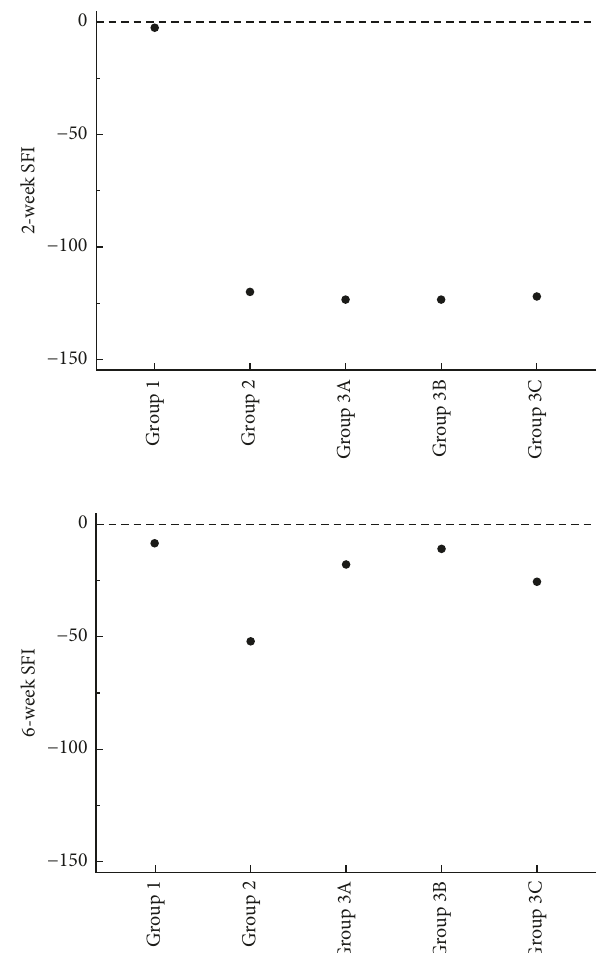
Figure 4: Median SFI values (dots) at 2 and 6 weeks for all groups. At 2 weeks postoperatively, the SFI value of group 1 is close to zero, indicating an uninjured sciatic nerve ( P (cid:31) 0 . 02, statistical comparison between groups 1 and 2 via the Mann-Whitney test). In groups 2 and 3 (A, B, and C), all of the SFI values exceed 100, indicating total impairment. At 6 weeks postoperatively, all of the median SFI values for group 3 are higher than those for group 2 ( P (cid:31) 0 . 02, statistical comparison among all groups via the Friedman −